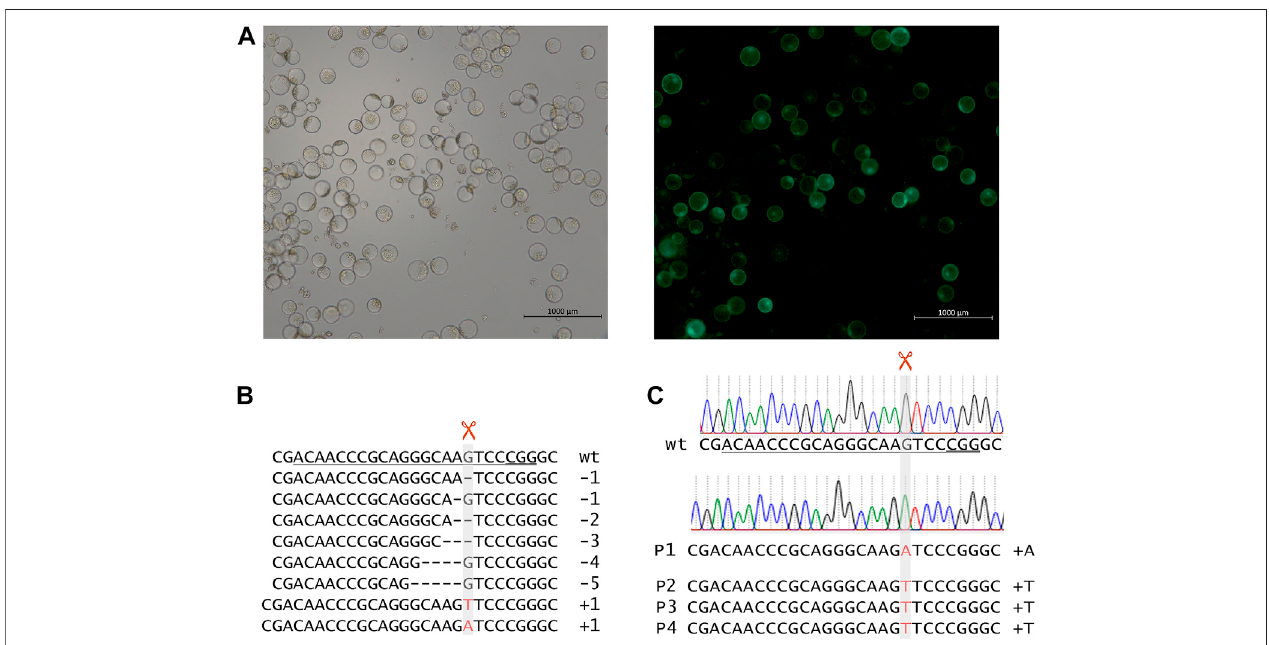
FIGURE 2 | (A) Mesophyll protoplasts of winter barley cv. “ Igri ” after PEG-mediated transformation with a GFP -carrying vector, after 60 h of incubation at 21 ° C. These protoplasts serving as positive control for viability and genetic transformation, respectively, were recorded using bright fi eld (left) and epi fl uorescence (right) microscopy. (B) Deep-sequencingofampliconsoftargetregion1aftertransformationofbarleyprotoplastsusingvectorscarrying cas9 andtargetmotif1-speci fi cgRNA expression units. (C) Chromatograms of Sanger sequencing target region 1 of wild-type “ Igri ” as compared with primary mutant plants. The unambiguous DNA sequence indicates homozygosity of the inserted A nucleotide. Grey vertical bars: cleavage positions, horizontal lines: deletions, red letters: insertions, wt: wild-type sequence, target motifs underlined with PAMs being double underlined, +A: 1-bp insertion of adenine nucleobase, +T: 1-bp insertion of thymine nucleobase.